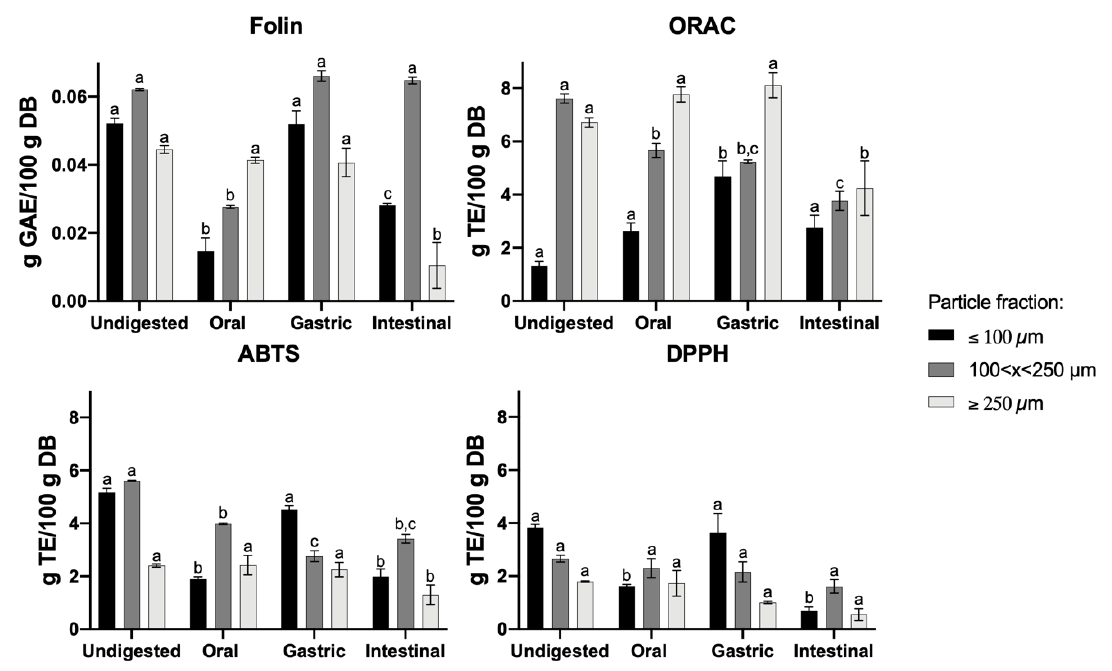
Figure 3. Total phenolic compounds (Folin–Ciocalteu method) and antioxidant capacity (ORAC, ABTS and DPPH assays) of carob flour with different particle sizes in the simulated GIT. All results expressed in g/100 g on dry basis (DB). The bars represent the standard deviation; for a given fraction, results with different letters differ significantly throughout GIT digestion.